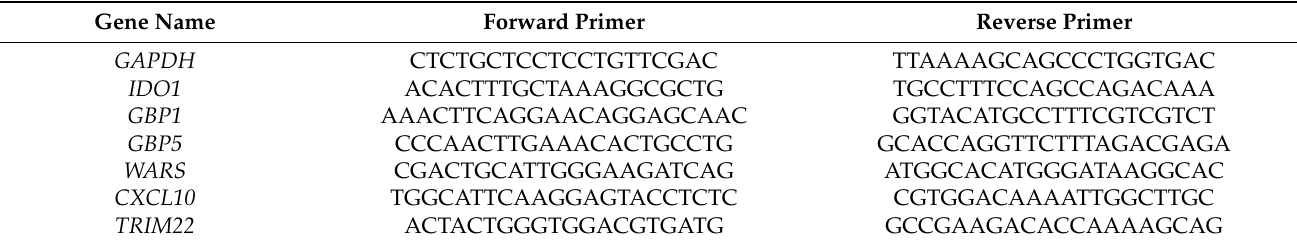
Table 1. Primer sequences used for